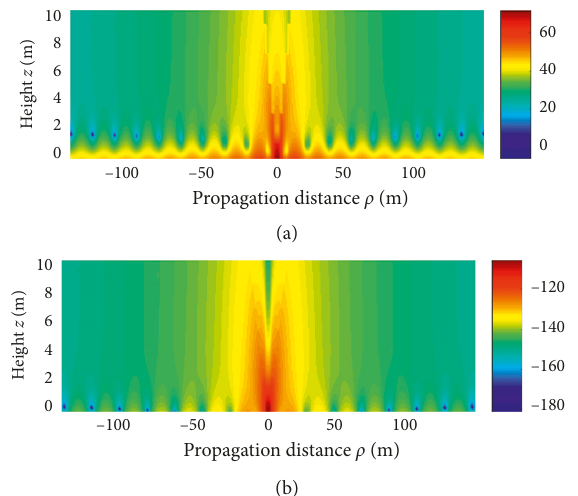
Figure 10: Spatial distributions in 􏽢 ρ − 􏽢 z plane of the electromagnetic field in dB due to a vertical electric dipole above a dielectric-coated ( ρ ,z )| and (b) | B ( ρ ,z )| conductor. (a) | E 0 z 0 Φ